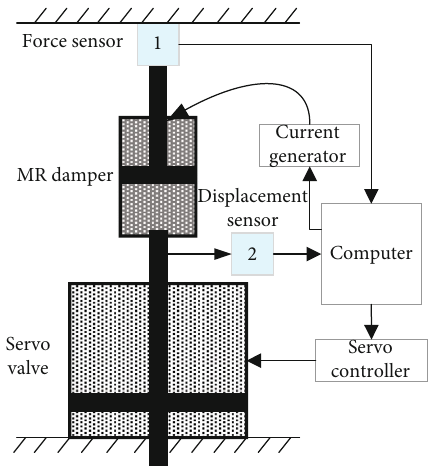
Figure 3: Schematic diagram of the damping characteristic test system for the MR damper.